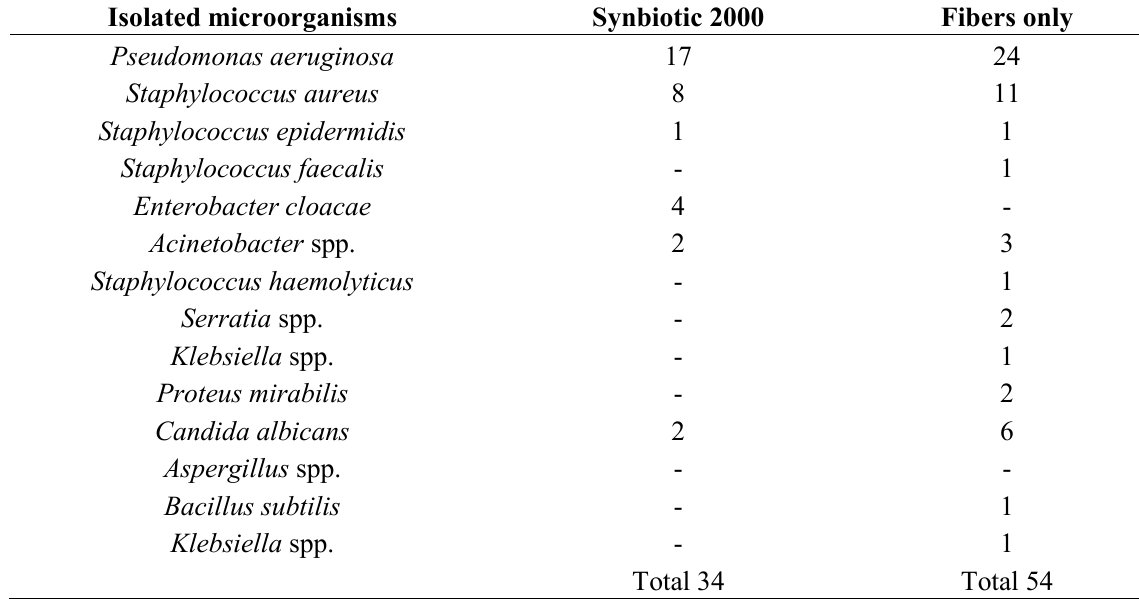
Table 7. Pathogens recovered from patients undergoing surgery for abdominal cancer treated with Synbiotic 2000 and only the fibers in Synbiotic 2000, respectively